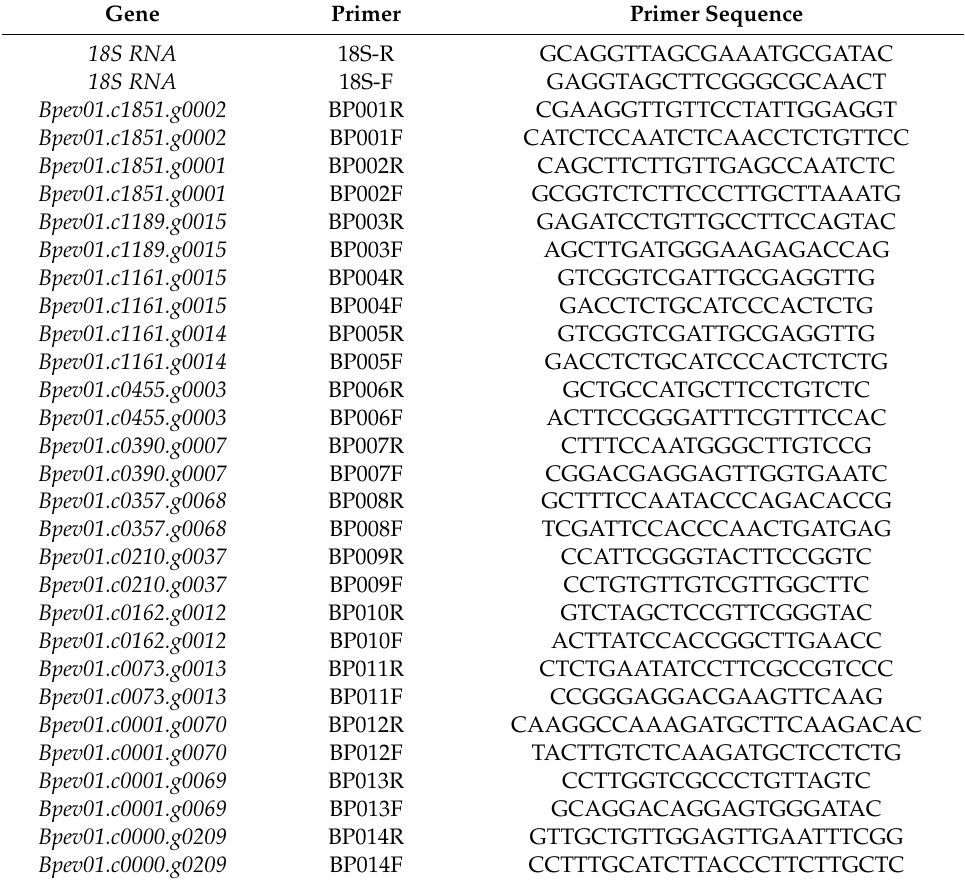
Table A1. The genes and primers used for qRT-PCR analysis.